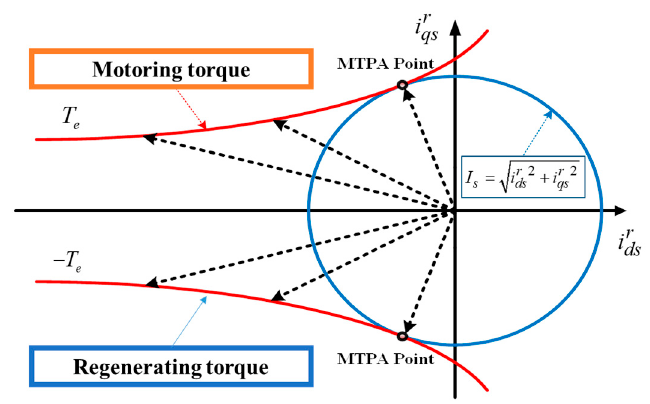
Figure 3. Combination of currents generated from the same torque.